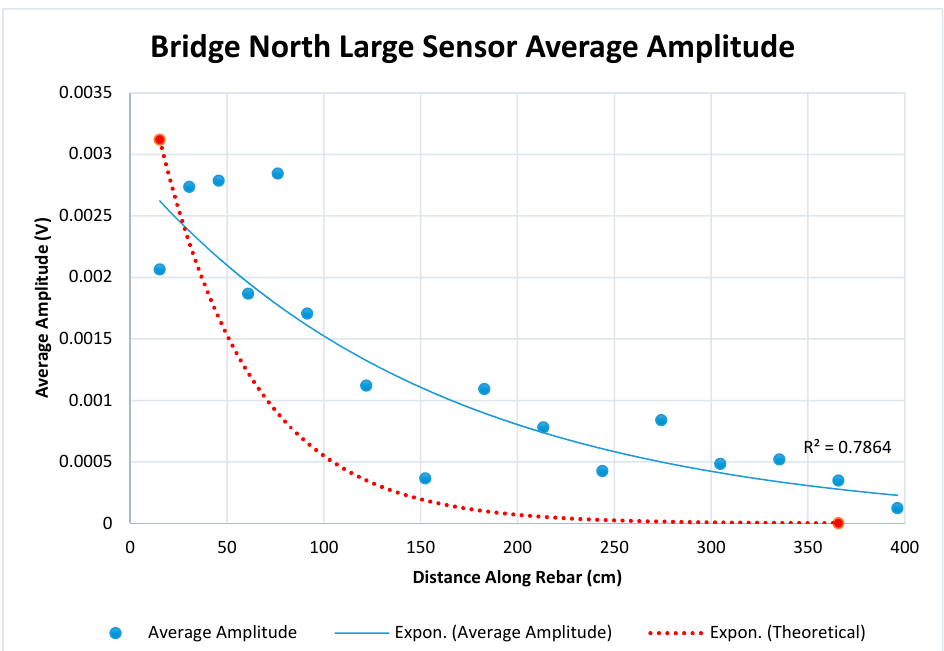
Figure 21. Sample results from Emerald Bridge pilot field testing.